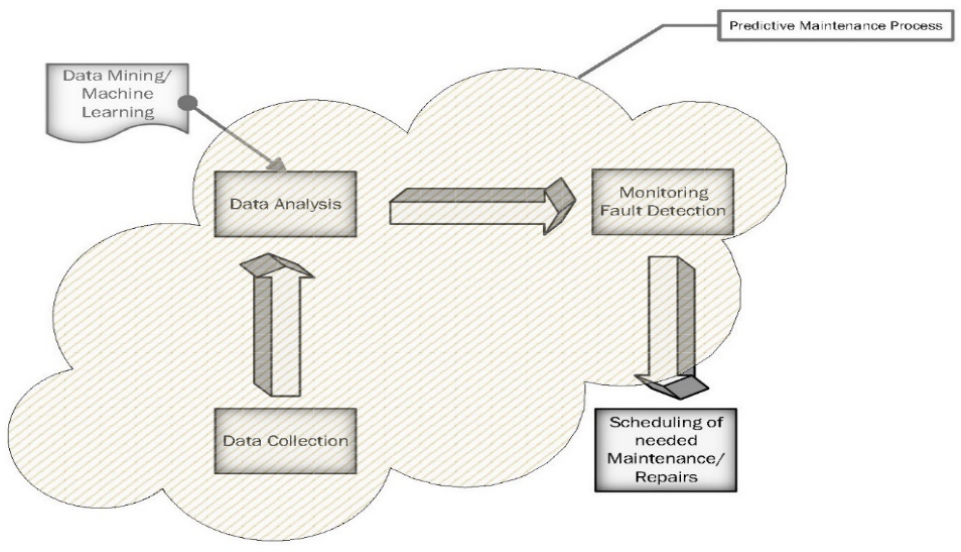
Figure 4. PdM’s general